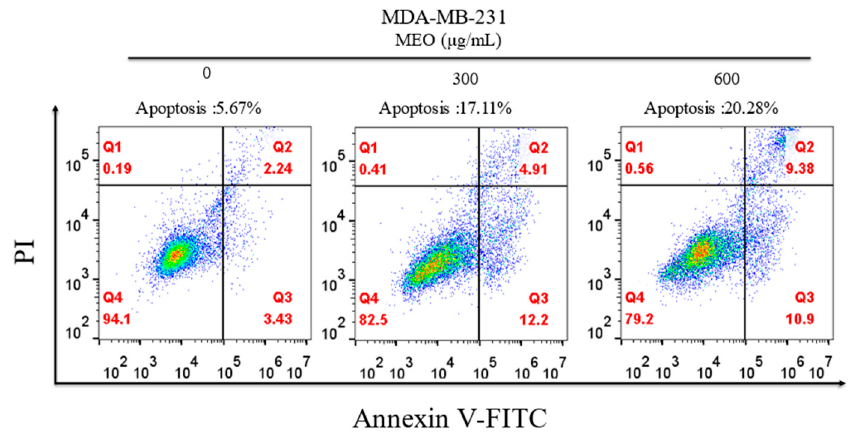
Figure 9. Flow cytometry analysis of MDA-MB-231 cells treated with